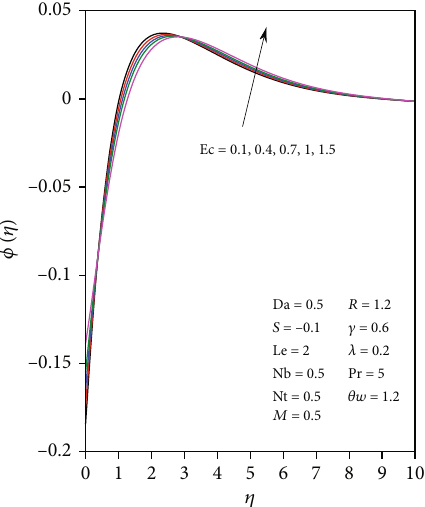
Figure 16: Concentration of nanoparticle pro fi le for di ff erent values of S .